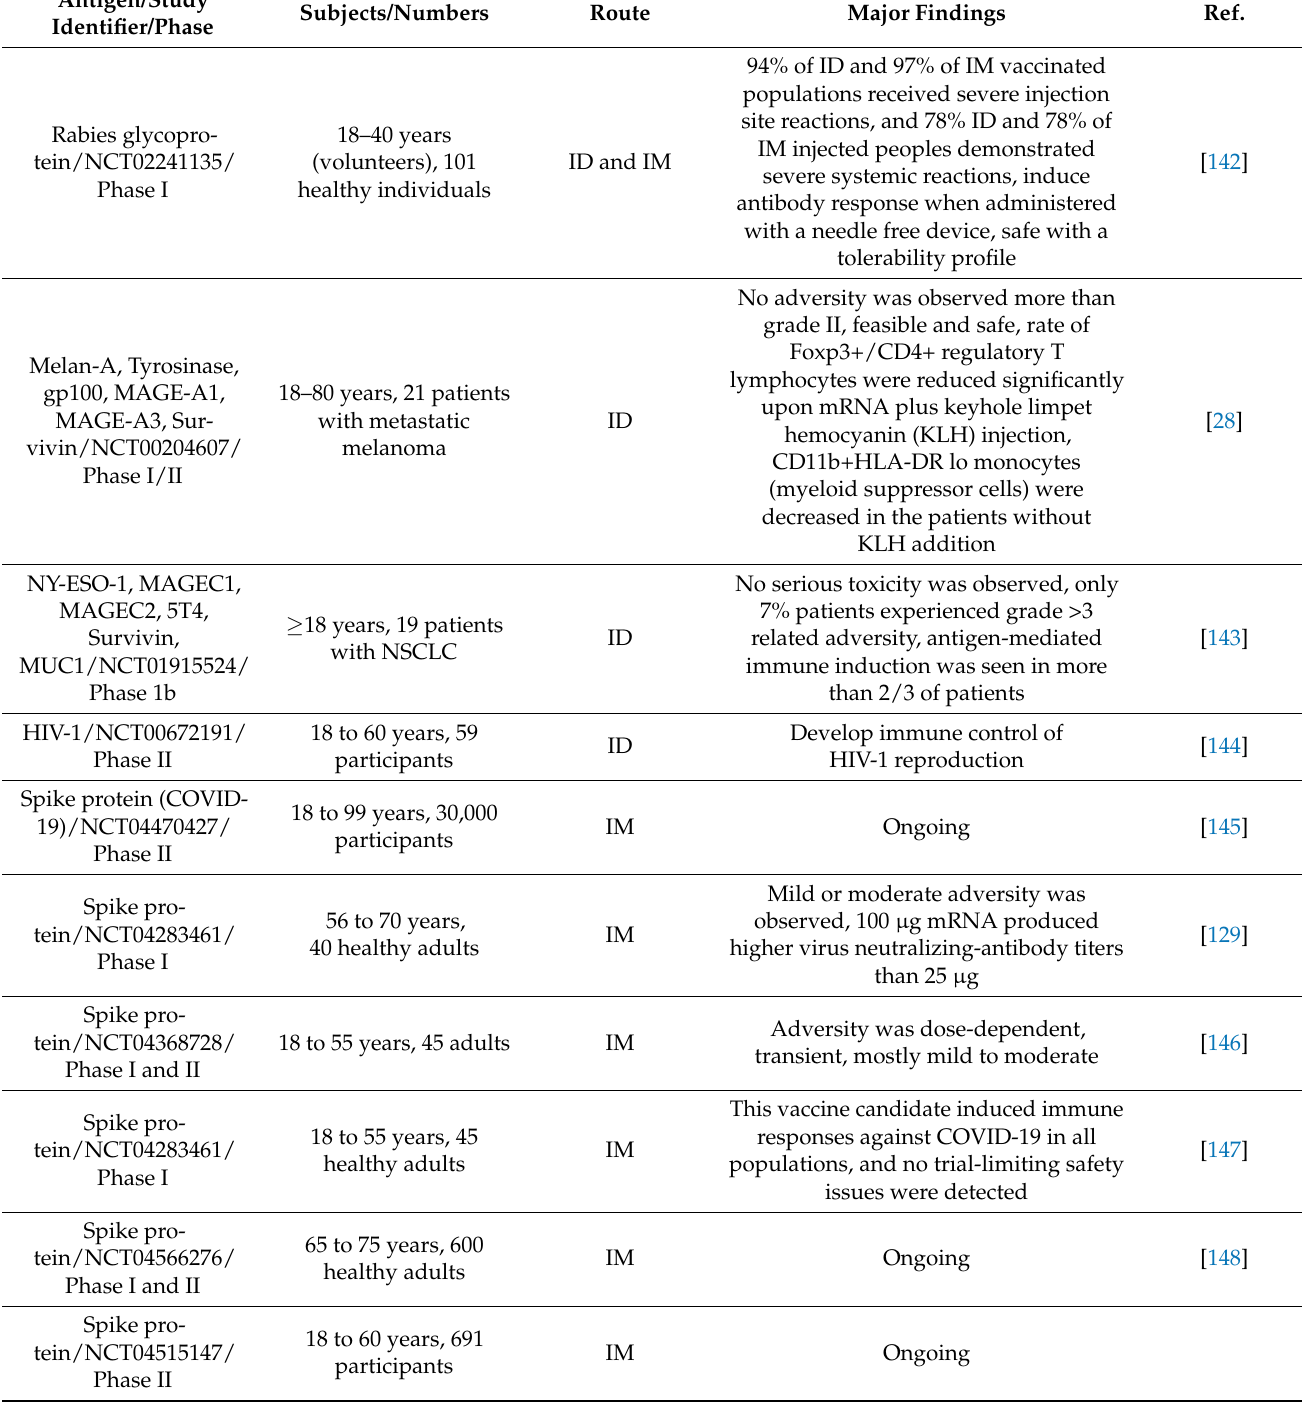
Table 3. mRNA-based vaccines in human clinical trials with their major finding and